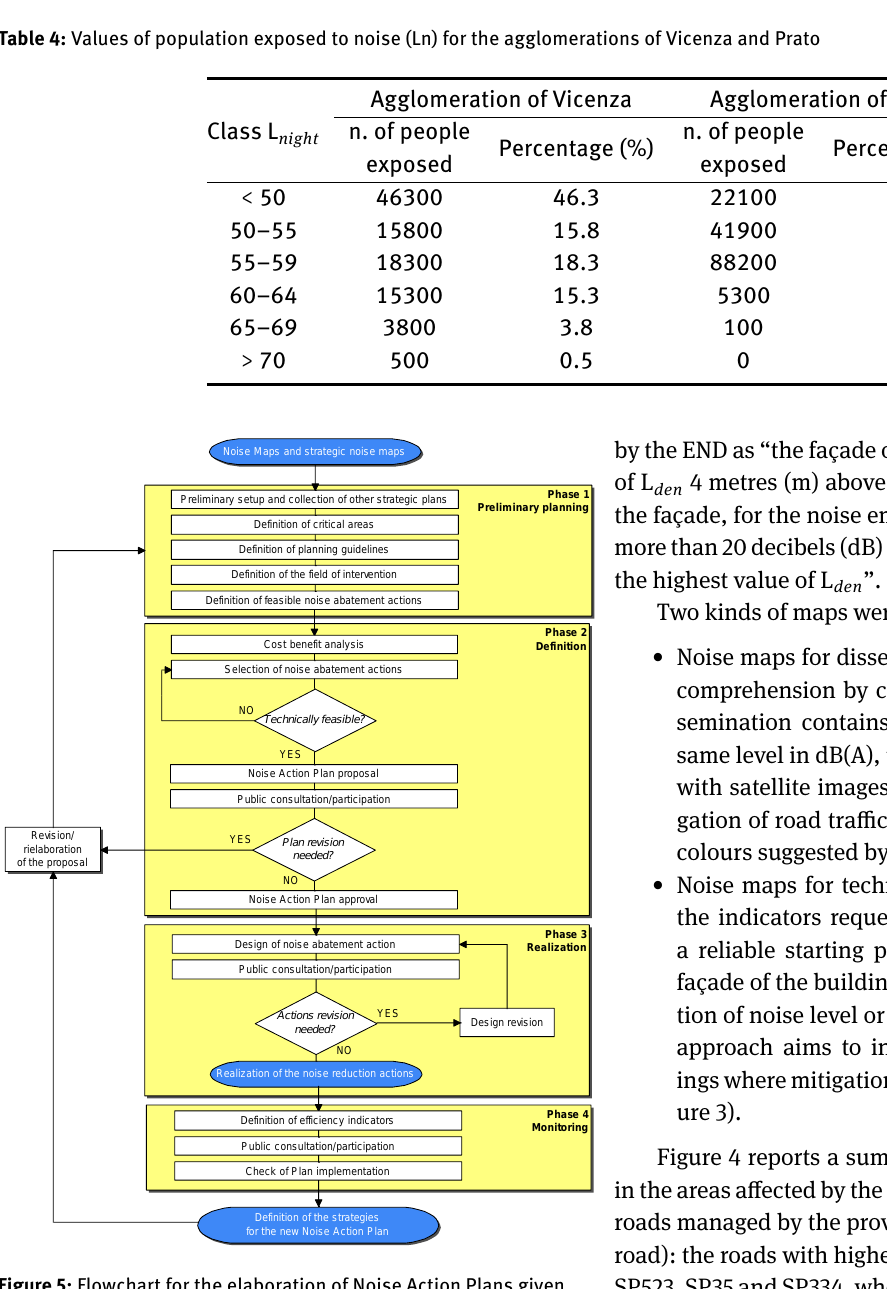
Table 4: Values of population exposed to noise (Ln) for the agglomerations of Vicenza and Prato